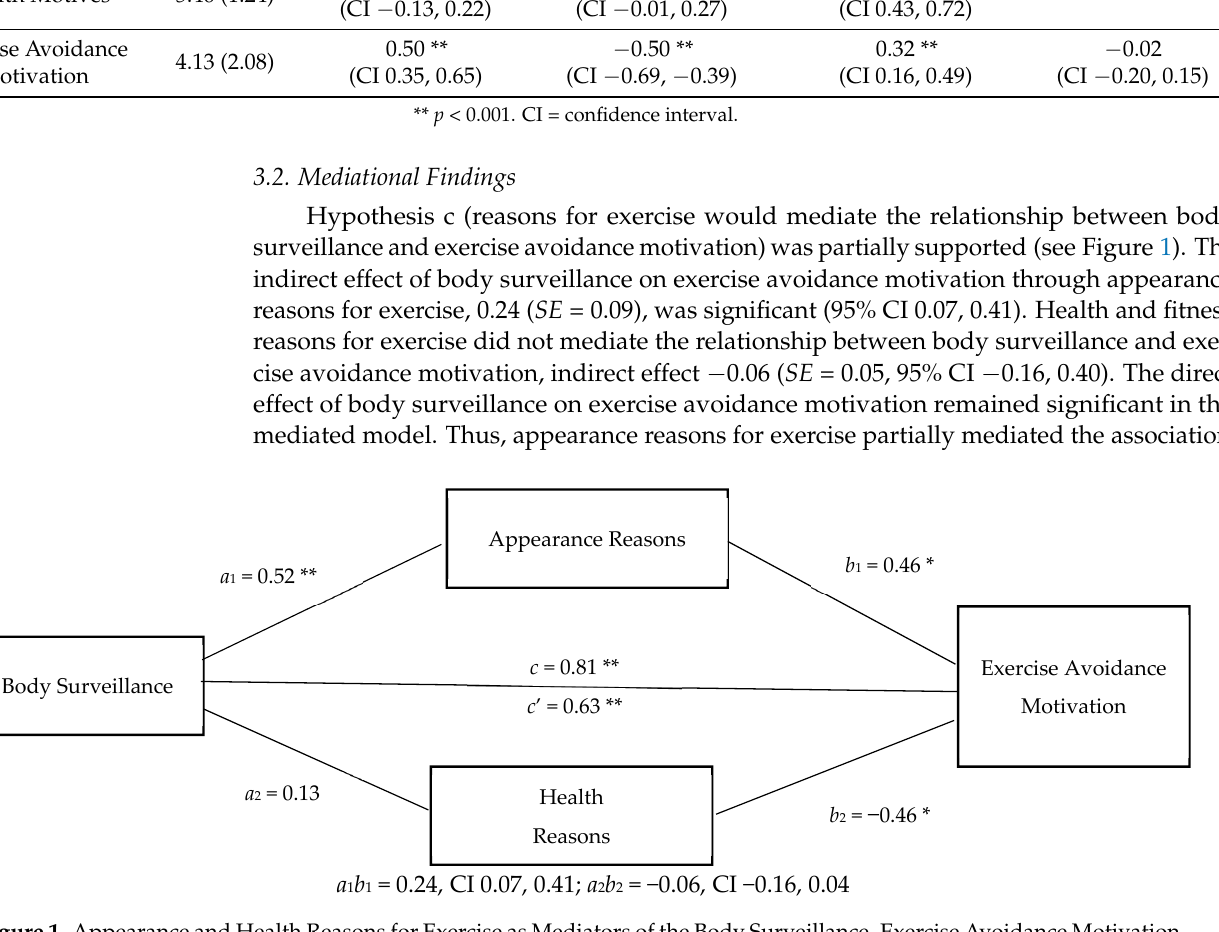
Table 1. Means, standard deviations, and correlations among study variables.